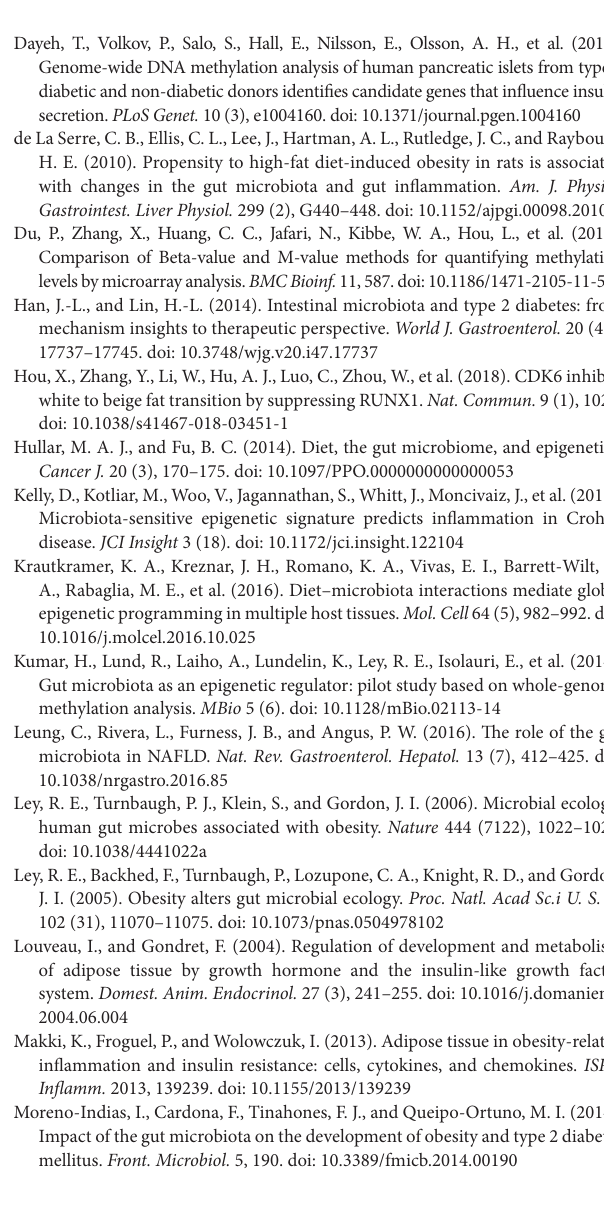
TABLE S1 | Baseline clinical characteristics of study subjects.